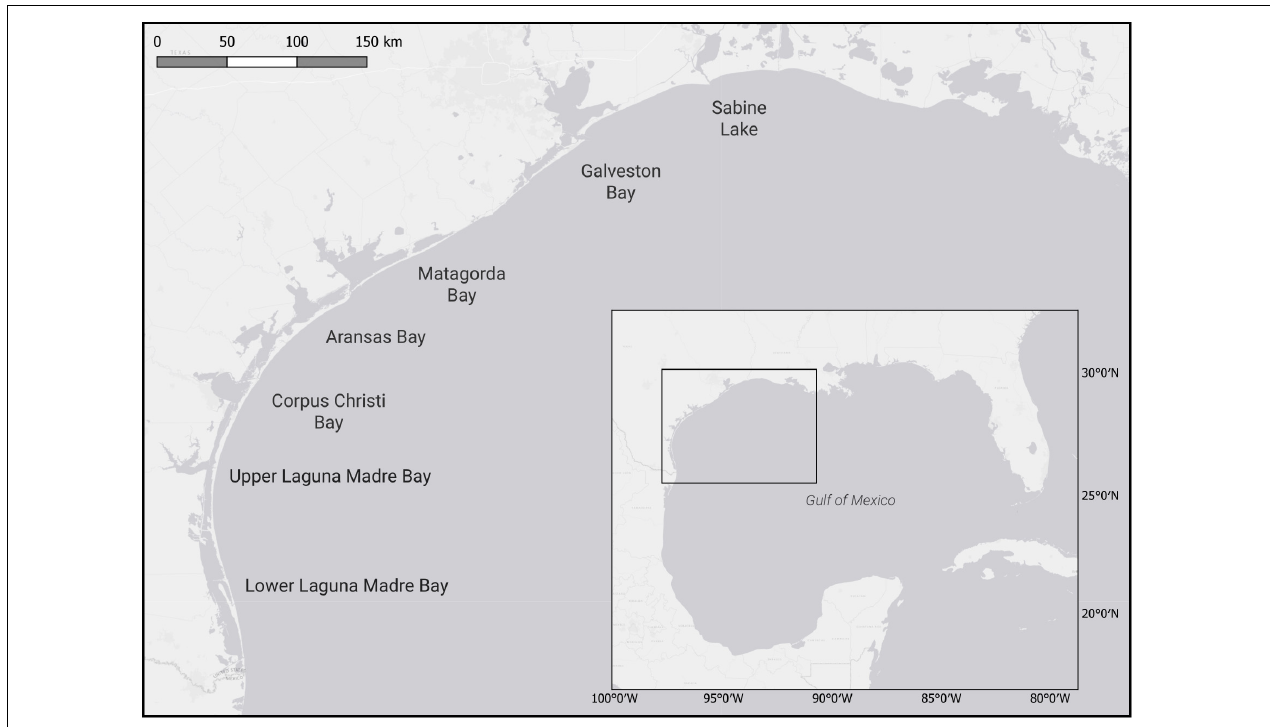
FIGURE 1 | Map of northwest Gulf of Mexico (nwGoM) estuaries from which juvenile bull sharks were collected. Box shows location of estuaries within Gulf of Mexico